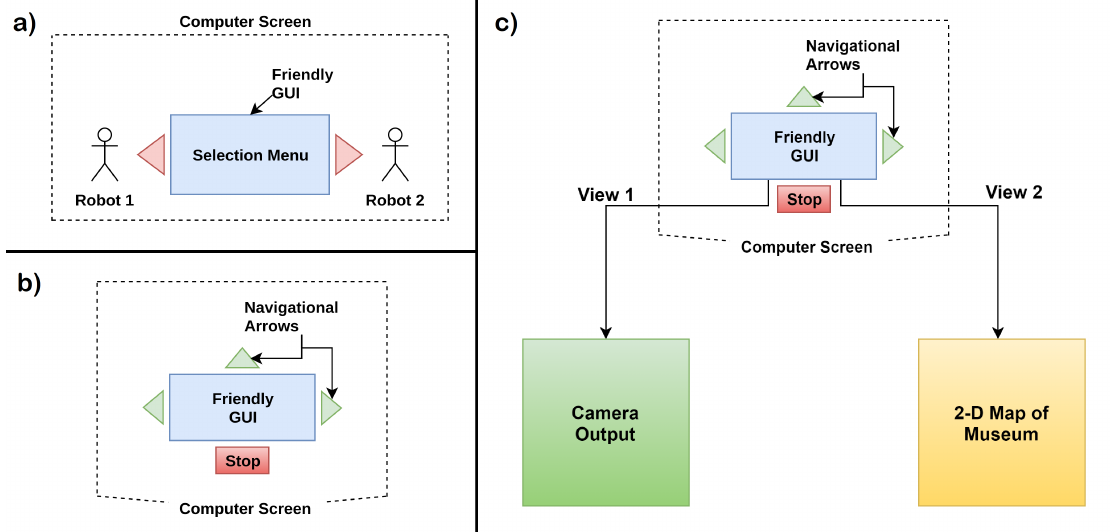
Figure 9. ( a ) Robot selection menu, ( b ) navigation screen, and ( c ) two views for the user (adapted from: